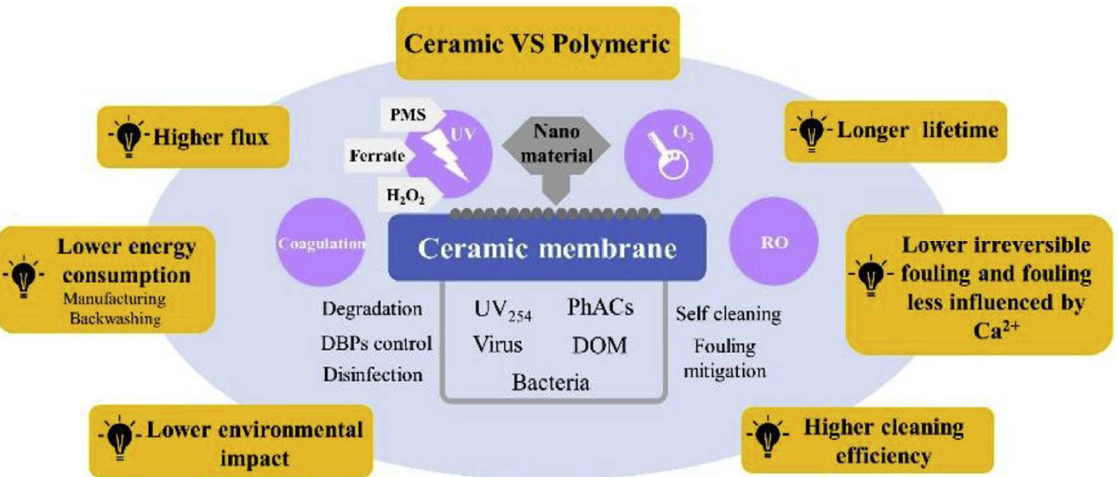
Figure 18. Concept of membrane surface construction to mitigate oily wastewater problem, using SiO 2 as the support layer and GO as the isolation layer